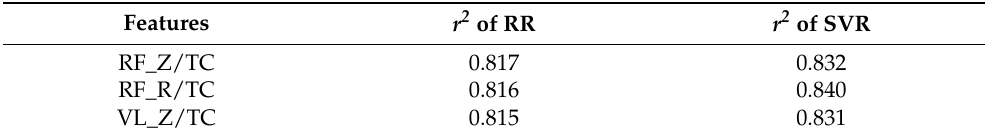
Table 5. Regression coefficient ( r 2 ) for the RR and SVR models when adding combined features, RF_Z/TC, RF_R/TC, and VL_Z/TC, separately.